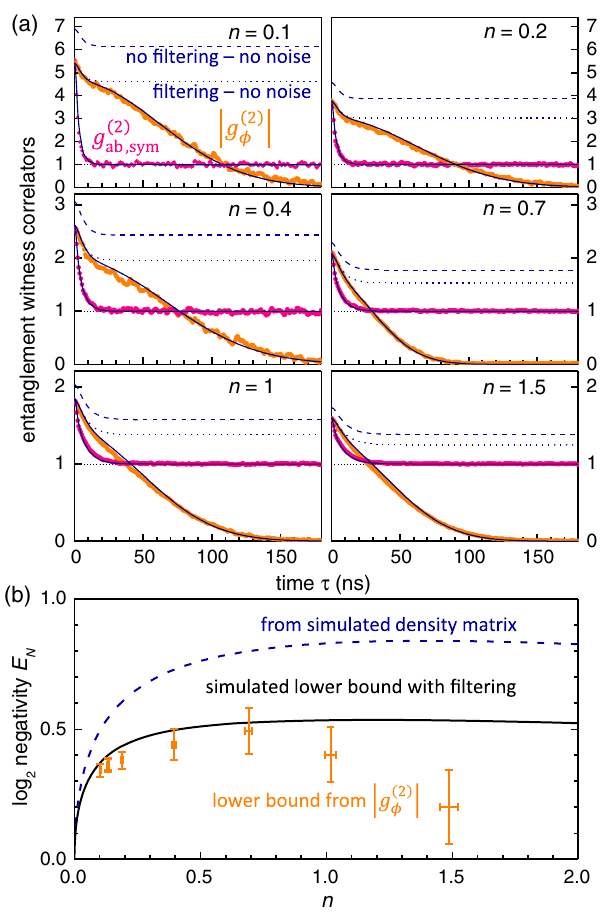
FIG. 4. Demonstration of entanglement. (a) Measured (dots) and simulated (solid lines) two-times fourth order in field 2 Þ 2 Þ τ , correlators g ð and g ð ϕ (see text) as a function of delay ab; sym for different Josephson energies leading to the indicated pop- ulation n . Dashed and dotted lines correspond to simulations without voltage noise and with (dotted) and without (dashed) filtering by the measuring lines. (b) log 2 negativity of the intraresonator fields as a function of population n . Exact value obtained directly from the numerically simulated density matrix of the system (dashed line), and experimental (error bars) and simulated (solid line) lower bound value corresponding to the filtering by the measuring lines (see